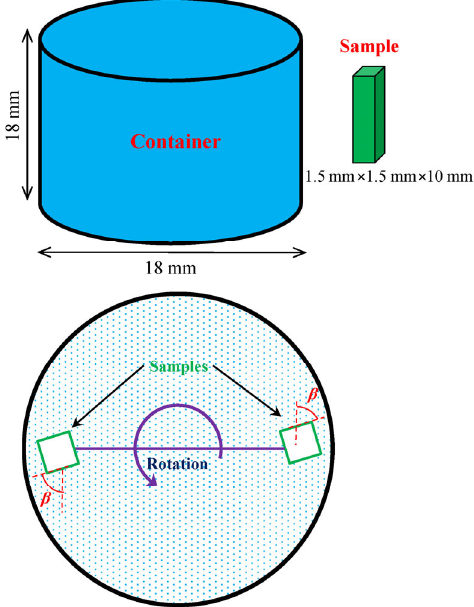
Fig. 12 Container, samples, and section view for the flow-erosion simulations.